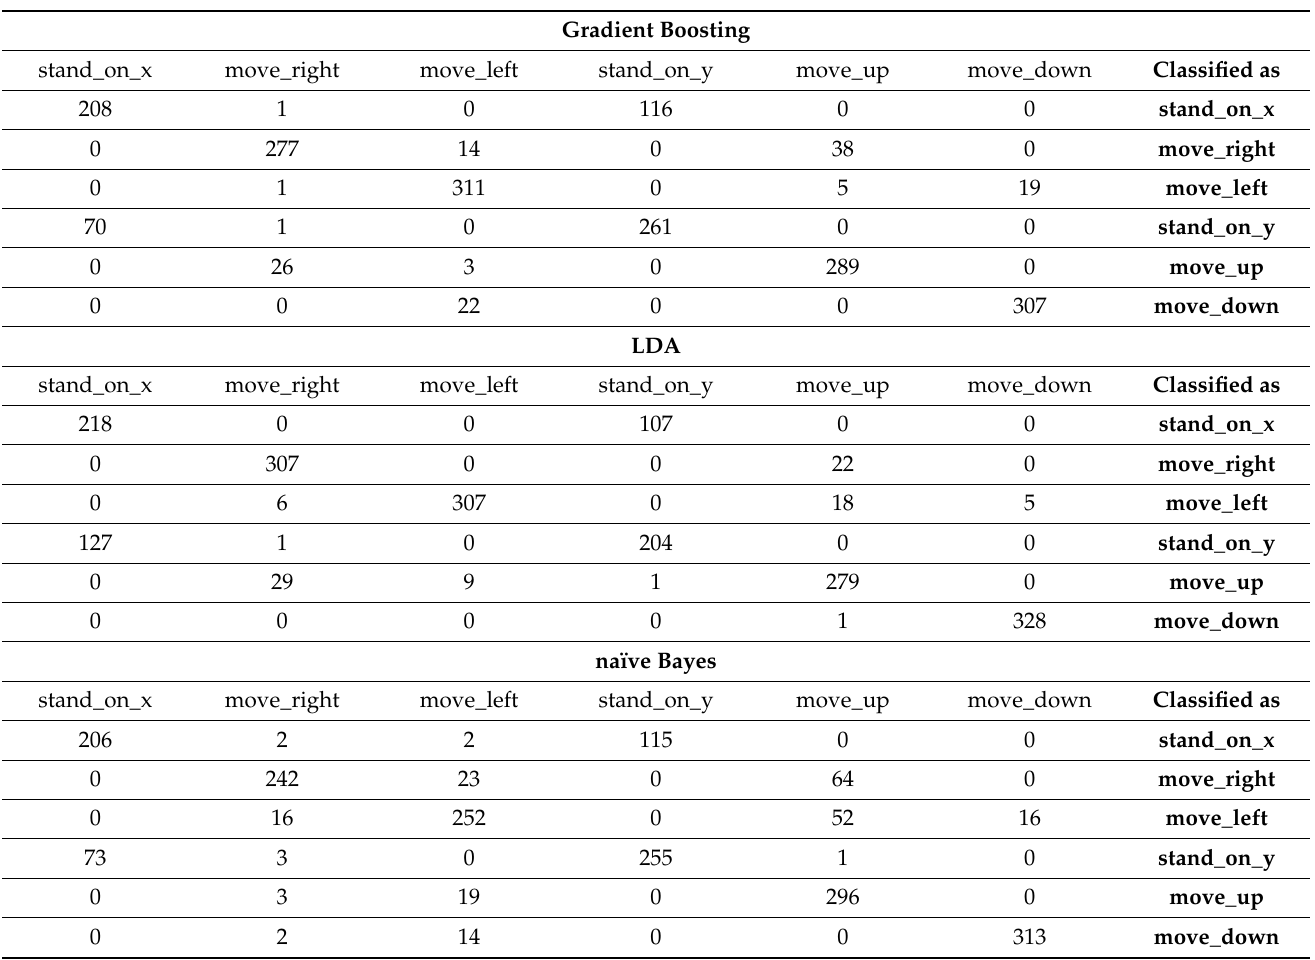
Table 6. Confusion matrices for top three classifiers. Gradient